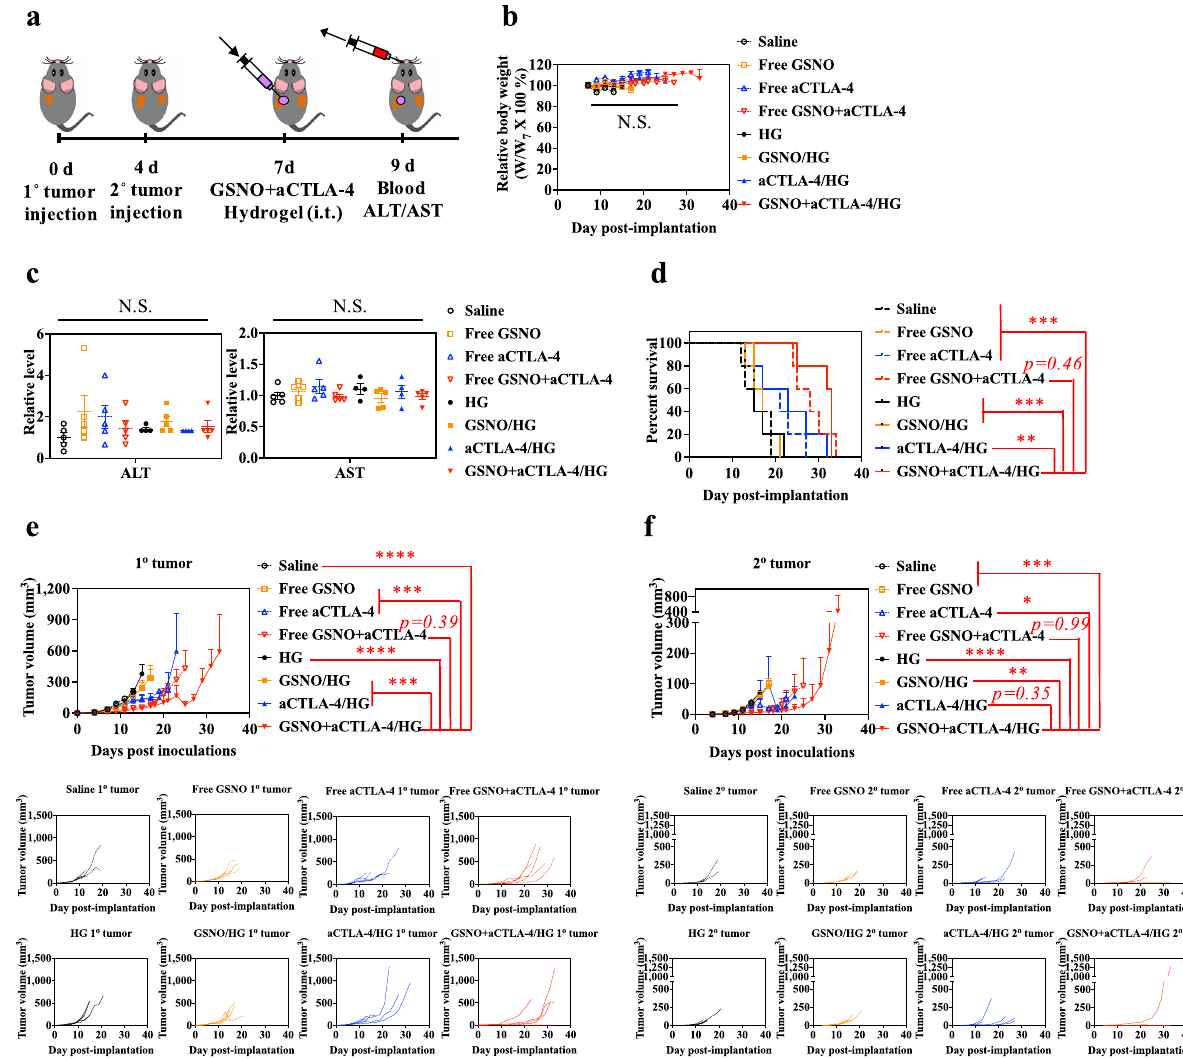
Fig. 6 Direct and abscopal effects of GSNO and aCTLA-4 loaded F127- g -Gelatin hydrogel. a Tumor model and treatment schedule. 1 o and 2 o tumors were formed in C57Bl/6 mice by inoculation of 10 5 B16F10-OVA cells in 30 μ L saline on day 0 and day 4, respectively. GSNO (570 μ gkg − 1 ) and aCTLA-4 (50 μ g mouse − 1 ) were administered intratumorally on day 7 in a total volume of 30 μ L in saline or 4.5 wt.% F127- g -Gelatin hydrogel. Blood was harvested from the facial vein on day 9 for assessment using the ALT/AST assay ( n = 4 for HG and aCTLA-4/HG, and n = 5 for the other). b Relative body weight changes post treatment ( n = 5). c ALT/AST activities of blood taken from mice 2d after treatment ( n = 5). d Kaplan – Meier survival curves ( n = 5). e 1 o (directly injected) tumor size ( n = 5). f 2 o (uninjected) tumor size ( n = 5). Data are presented as individual biological replicates and mean±SEM. *****p < 0.0001, ****p <0.001, ***p <0.01, **p < 0.05, and *p < 0.1. Exact p -values for d – f are reported in Supplementary Tables 8 and 9. b Two-way ANOVA using Tukey post-hoc statistical hypothesis. c One-way ANOVA using Tukey post-hoc statistical hypothesis. d Log-rank using Mantel – Cox statistical hypothesis. e , f ANOVA using linear mixed-effects model. Source data are available in a Source Data fi